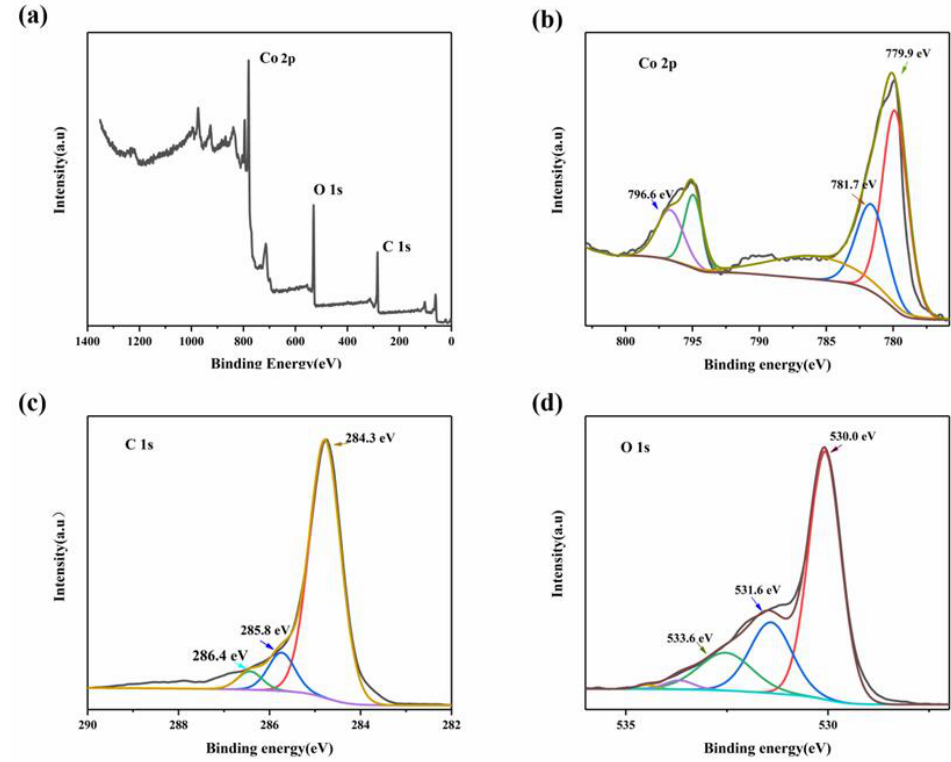
Figure 5. MWCNT3@Co 3 O 4 ( a ) XPS full spectrum; ( b ) Co 2p; ( c ) C 1s and ( d ) O 1s XPS spectrum of fine spectrum.